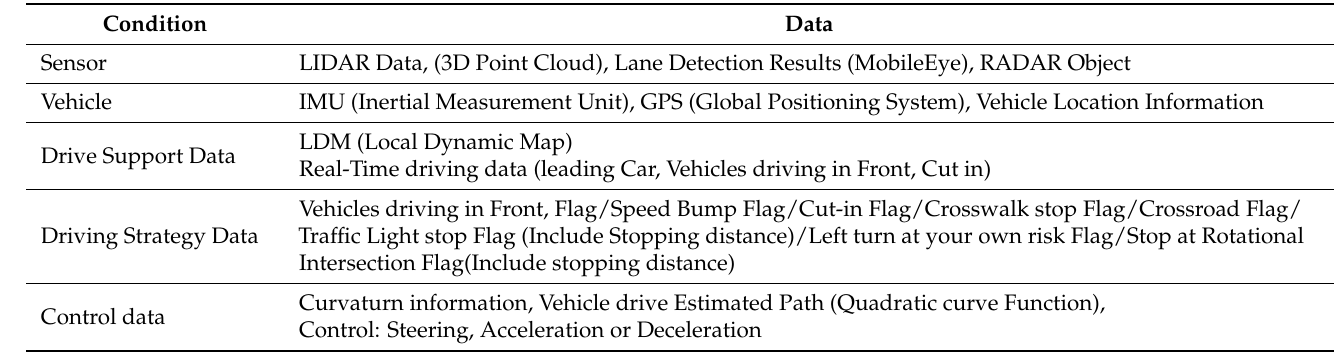
Table 4. Certification of vehicle accident